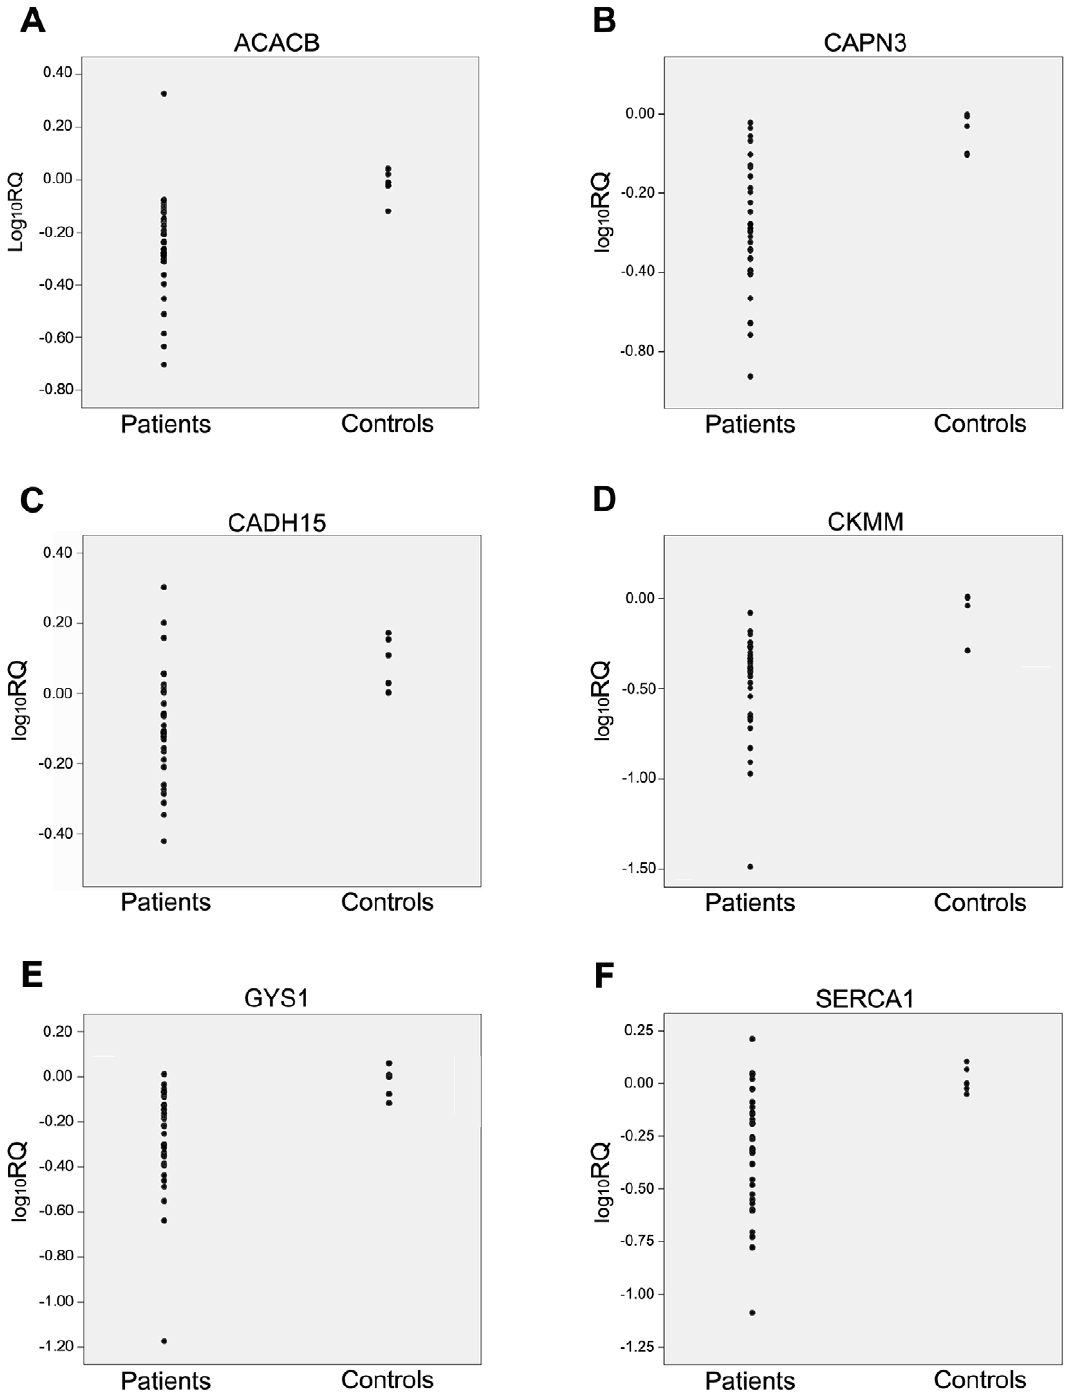
Figure 1. Scatter-plots for the six genes presenting the highest differential expression between patients and controls ( p , 0.01). A. Acetyl-CoA carboxylase beta ( ACACB ); B. Calpain III large subunit ( CAPN3 ); C. M-cadherin ( CADH15 ); D. Muscle creatine kinase ( CKMM ); E. Muscle glycogen synthase ( GYS1 ); F. Sarcoplasmic reticulum Ca 2 + ATPase 1 ( SERCA1 ). Each subject is represented by a dot.